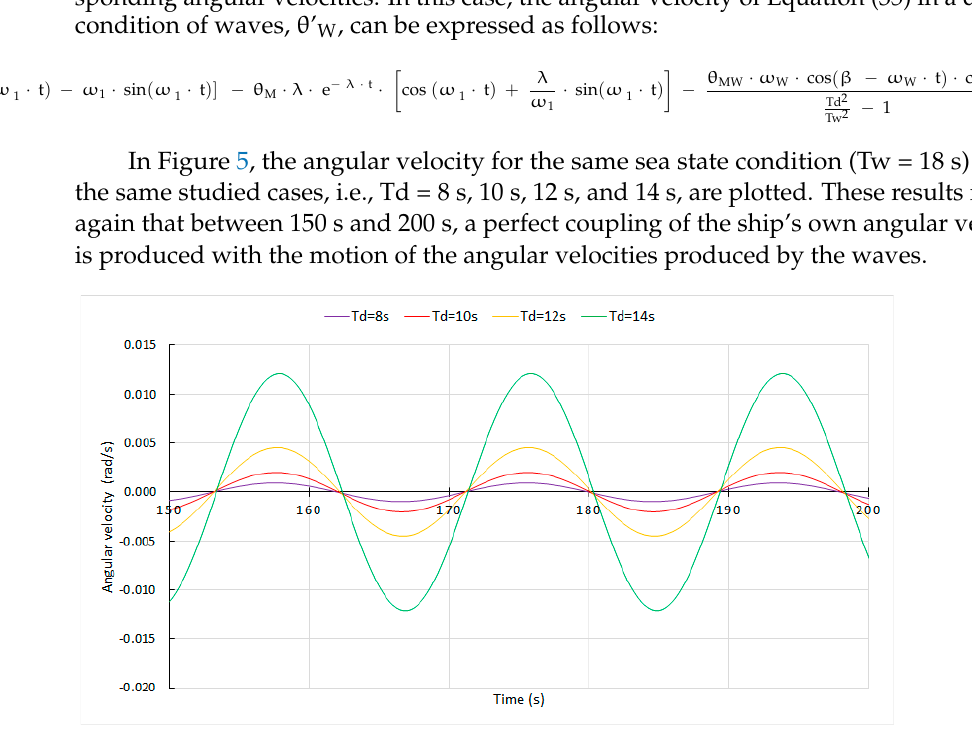
Figure 4. Rolling angles reached by different ship loading conditions for Tw = 18 s.